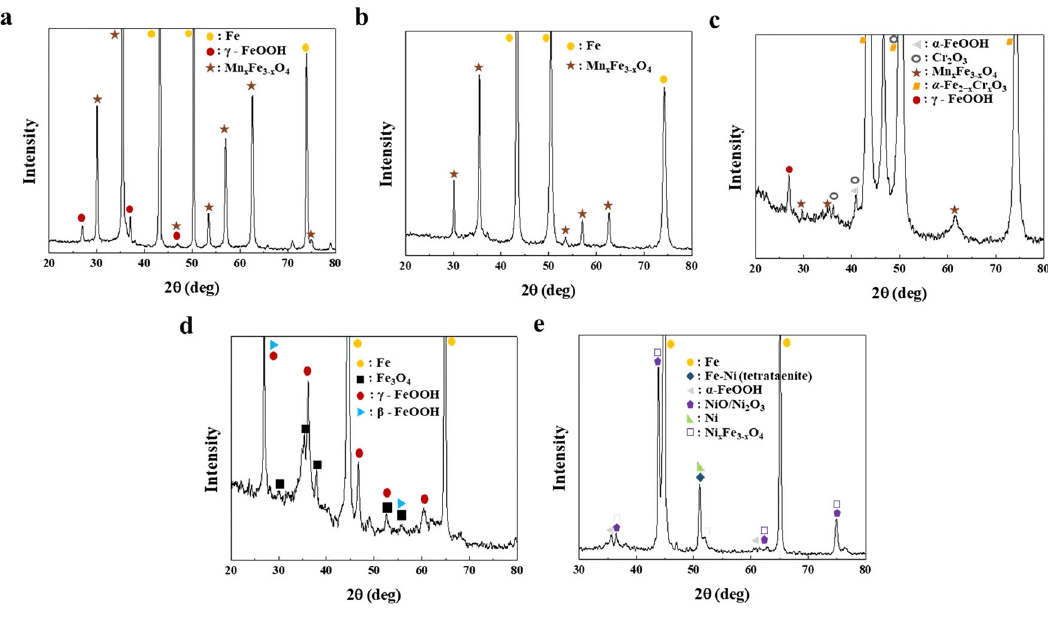
Fig. 4 XRD patterns of the samples (28 days of immersion in a 3.5% NaCl solution). a – e M_Mn, H_Mn, H_Mn-L_Cr, API X70, and 9Ni, respectively.